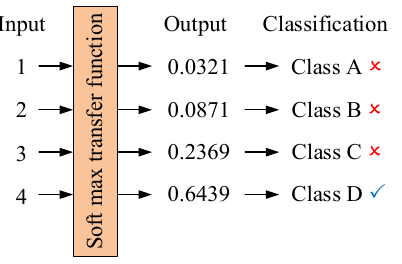
Figure 4. Hyperbolic tangent sigmoid transfer function.